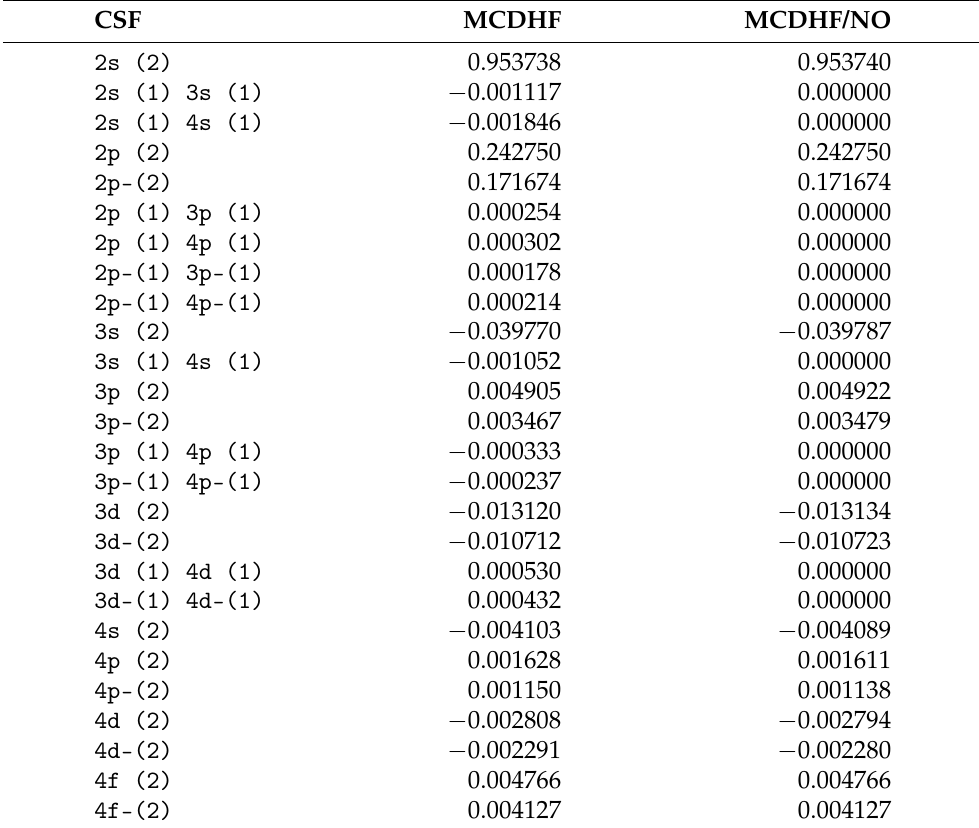
Table 3. Mixing coefficients for the n = 4 active space valence correlation expansion of the 1 s 2 2 s 2 1 S 0 ground state of Be, using two different orbital bases: the MCDHF-optimized orbitals and their corresponding natural orbitals